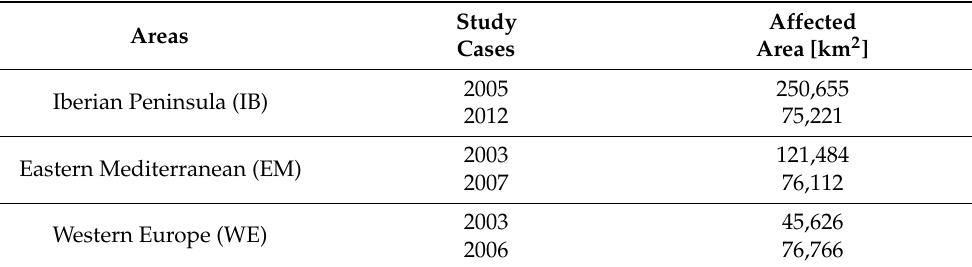
Table 1. Selected extreme events for each study area that had major impacts on vegetation productiv- ity between 2001 and 2019. The affected area corresponds to the regions under vegetative stress for 5 or more months, described in km 2